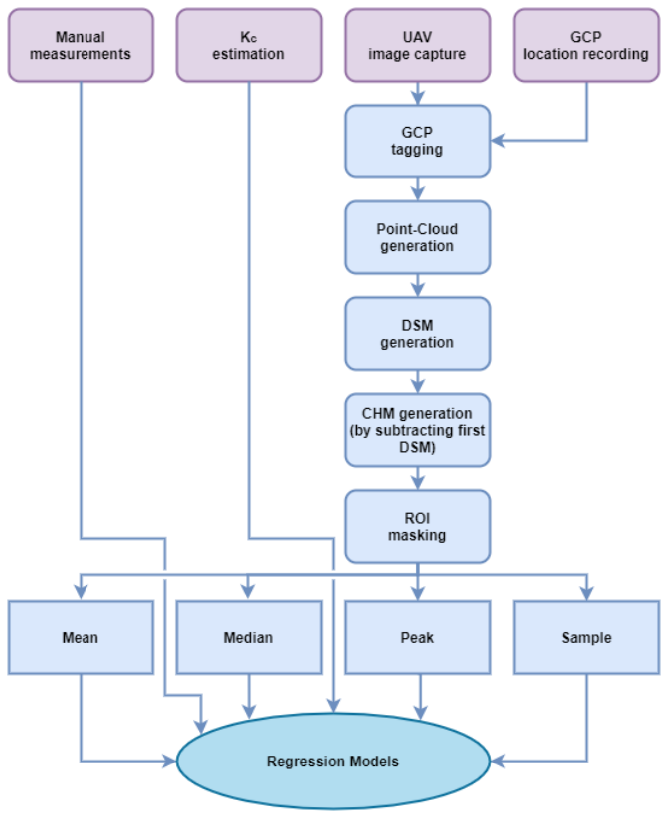
Figure 2. Flowchart describing the steps of data processing for height and K c models.